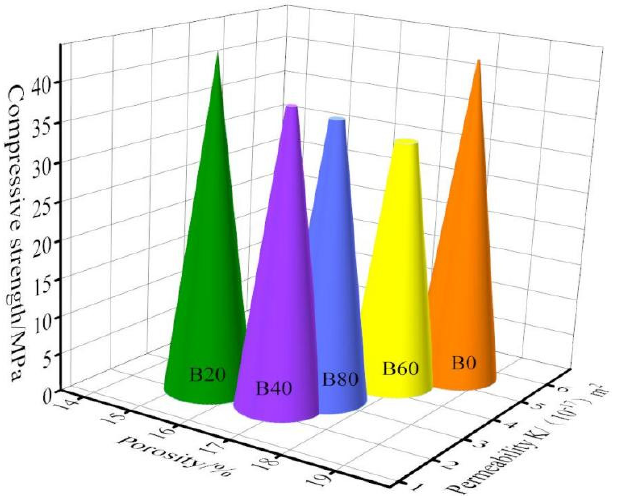
Figure 9. Relationship between porosity, gas permeability, and compressive strength.